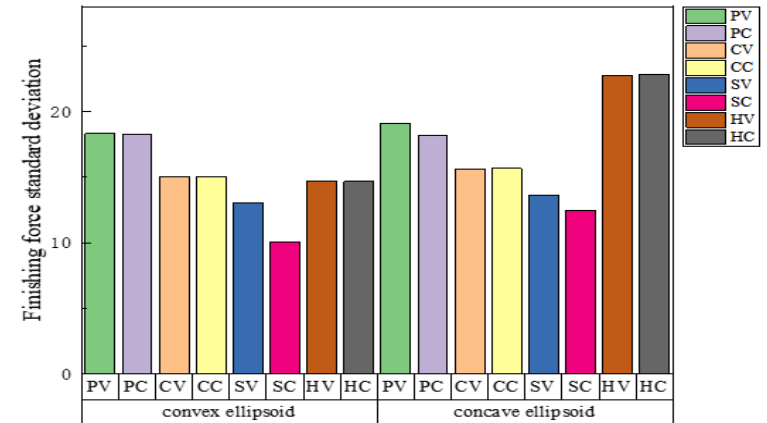
Figure 6. Trend diagram of tool path versus grinding force fluctuation.